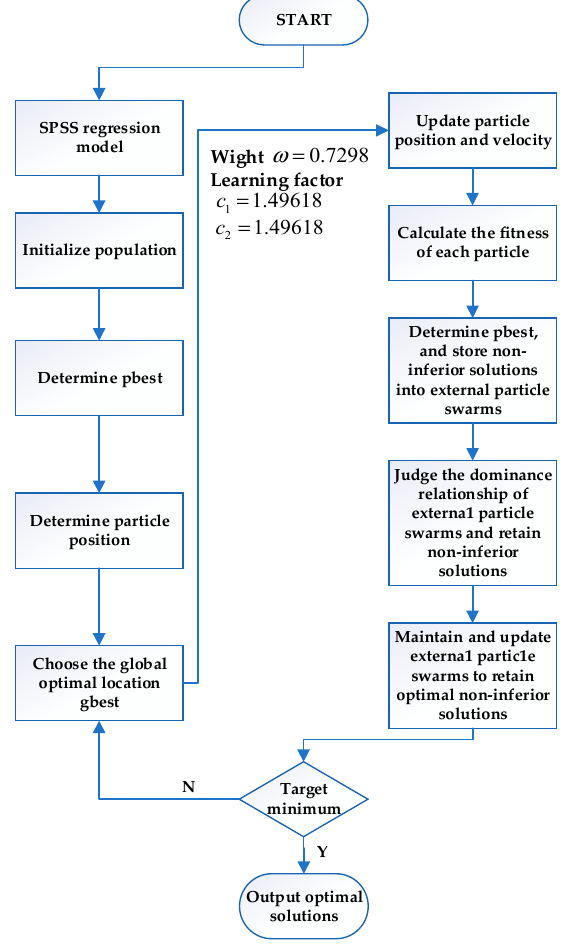
Figure 5. Flowchart of the MOPSO algorithm.